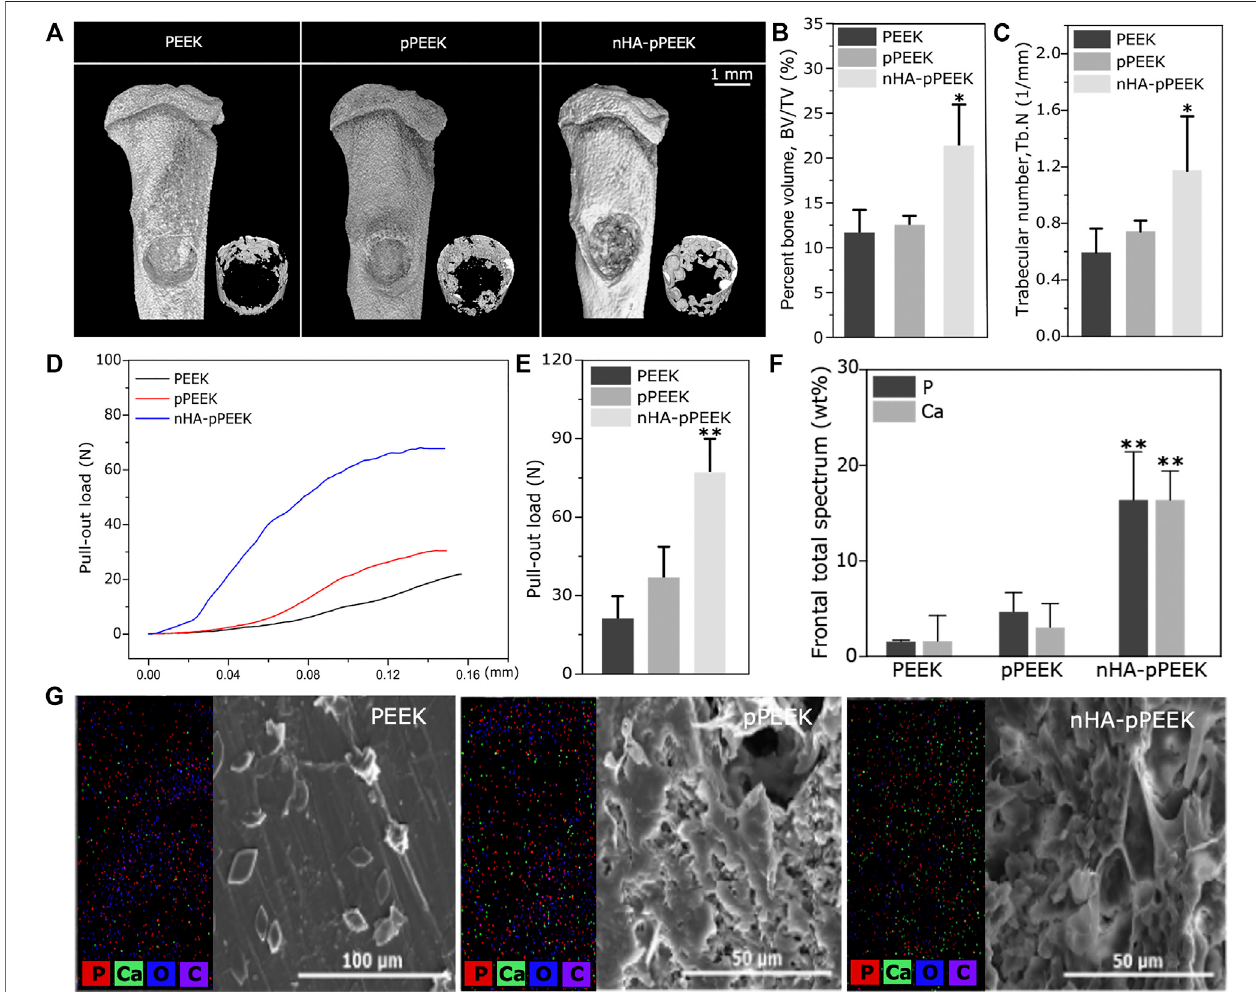
FIGURE 4 | In vivo analysis on osseointegration. (A) Three-dimensional images obtained from μ CT reconstruction. Overall pattern of tibia (upper); new bone in the defect part (lower). (B) BV/TV, and (C) Tb. N of the defective aera calculated using accessory software. (D) Pull-out strength of the implanted materials in all groups, havingdifferenteffectsonosseointegration. (E) Themaximumvaluesofpull-outloadtakenforquantitativeanalysis. (F) Quantitativeanalysesofphosphorusandcalcium. (G) The surface composition of each sample analysis by SEM-EDX system, including SEM images and distribution maps of the elements of carbon, oxygen, phosphorus, and